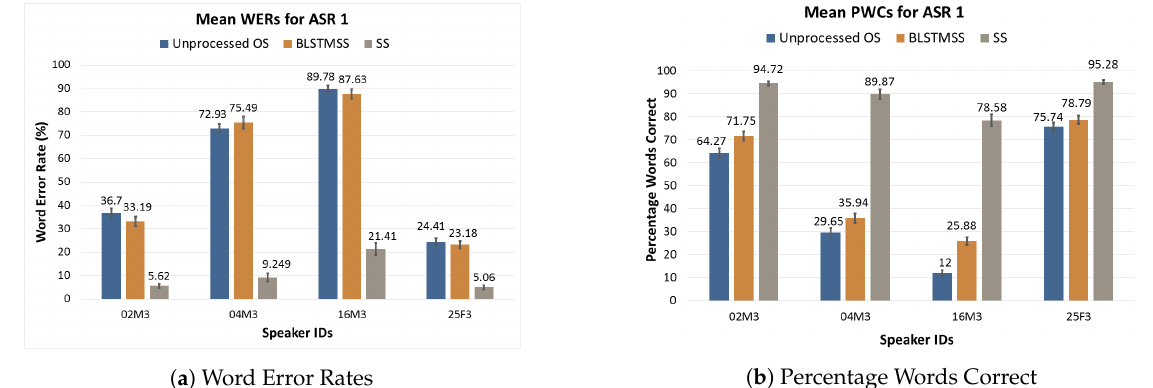
Figure 2. ASR 1 WER and PWC scores for unprocessed OS (source), the BLSTMSS converted outputs and target SS (target). Error bars show standard errors.